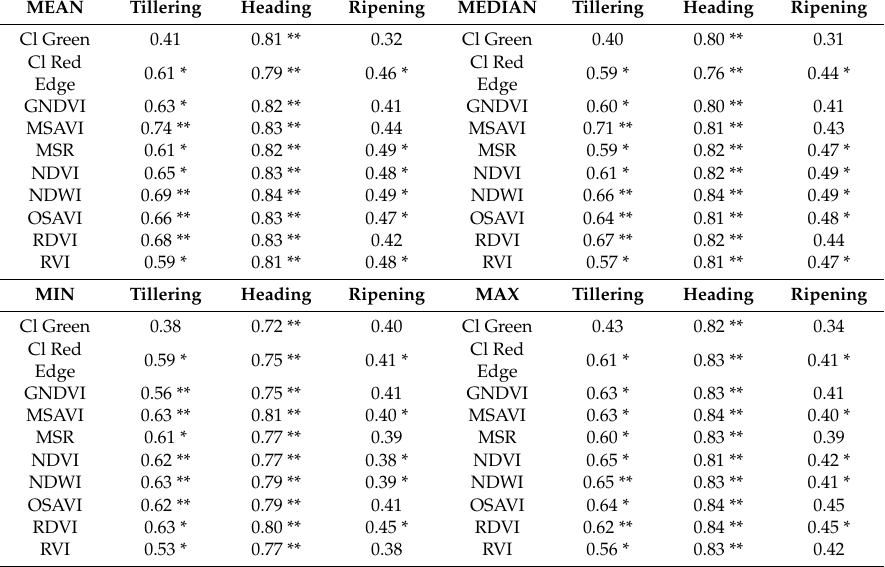
Table 6. Pearson correlation coe ffi cients (R). Relationship of vegetation indices (VIs) and grain yield at three phenological stages and four statistical approaches. Statistical significance is indicated by ** and * at 99% and 95%, respectively. MEAN Tillering Heading Ripening MEDIAN Tillering Heading Ripening Cl Green